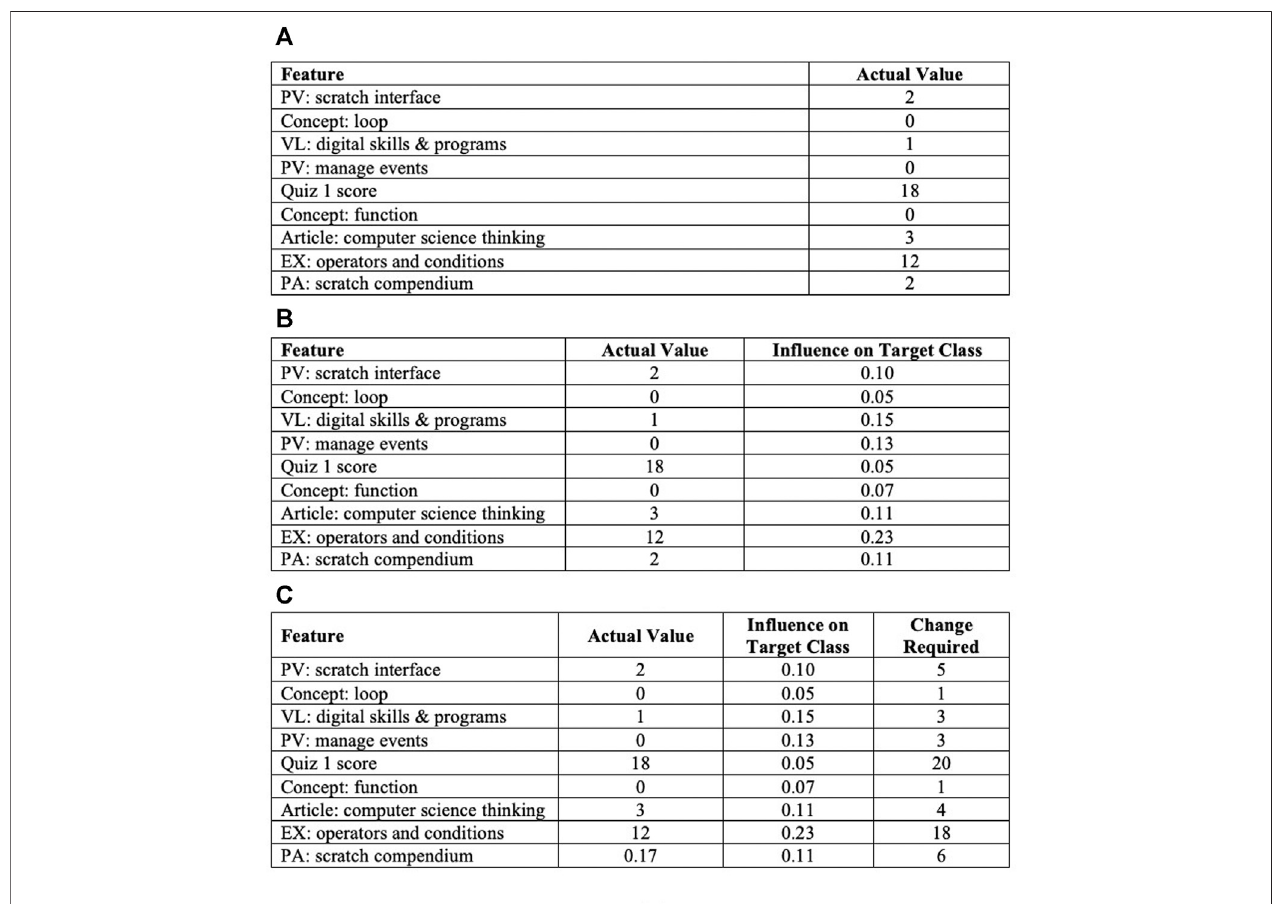
FIGURE 3 | The output of Algorithm 2 , which shows the extracted in fl uence value of each factor and change required to meet the desired